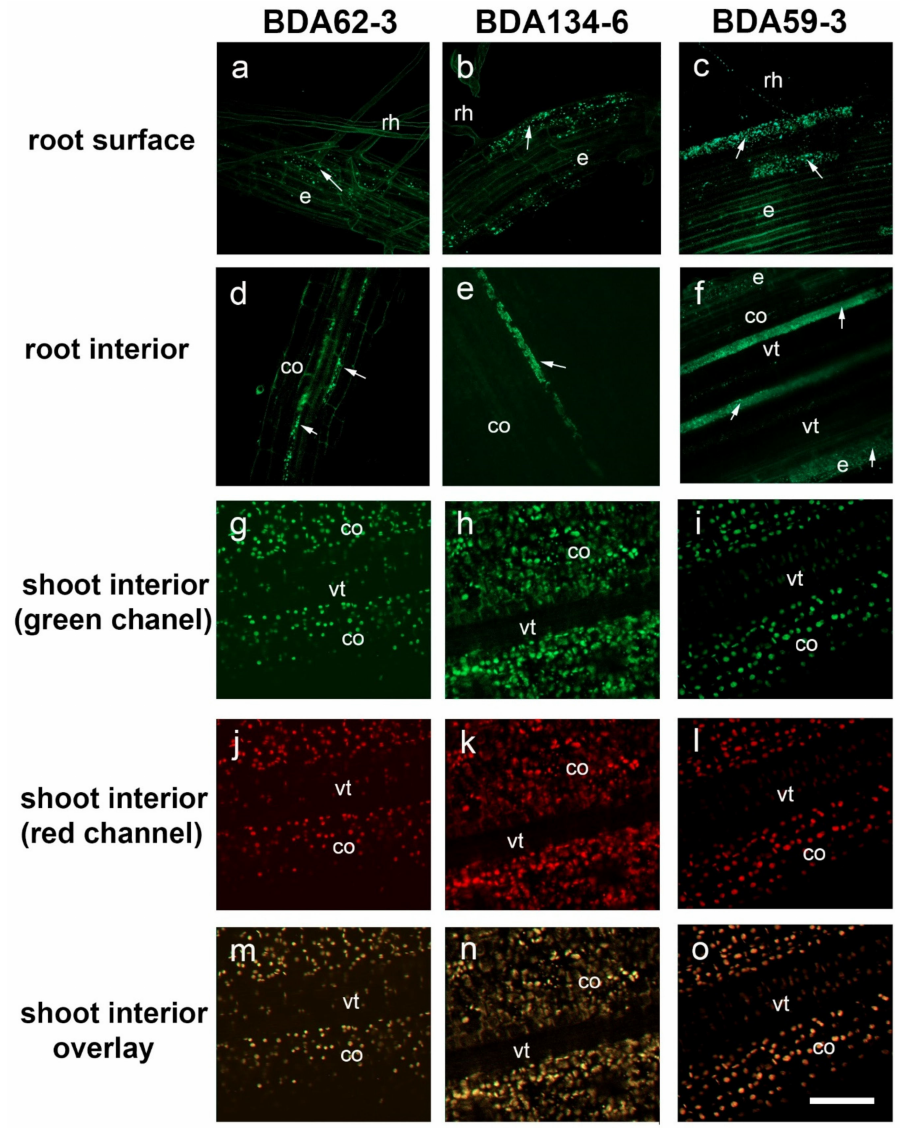
Figure 3. Visualization of the tagged strains Ko. pseudosacchari BDA62-3, Kl. pasteurii BDA134-6 and P. diazotrophicus BDA59-3 in O. sativa root and shoot tissues using confocal laser scanning microscopy (CLSM). Confocal analysis was performed on whole representative roots ( a – f ) and shoots ( g – o ) to show surface and inner colonization of the tagged bacterial strains. Images are projections of 10 optical sections for all panels except for panels ( g – o ) where projections were made of 20 optical sections. The focal step size was 4 µ m. ( a – c ) Detection of BDA62-3, BDA134-6 and BDA59-3 bacteria on the root surface and internal colonization of epidermal cells, including the modified epidermal cells (root hair cells). ( d – f ) The internal colonization of the intercellular spaces in the cortex and vascular tissues of the root differentiation zone. The interior of the vascular tissue was never observed invaded by any of the different bacterial strains. ( g – o ) Images of the shoots’ interior showing the cortex and the vascular tissues. ( g – i ) Bacteria were never detected in the shoots but chloroplasts, which are highly autofluorescent, were also detected using both the green ( g – o ) and the red channel ( j – l ). ( m – o ) Overlay of green and red panels of the rice shoots for the three bacteria strains showing overlay of the fluorescent signals for chloroplasts. No bacteria were visualized in green in any case. Bacteria colonization is arrowed. co, cortical cells; e, epidermal cells; rh, root hairs; vt, vascular tissue. Scale bar represents 50 µ